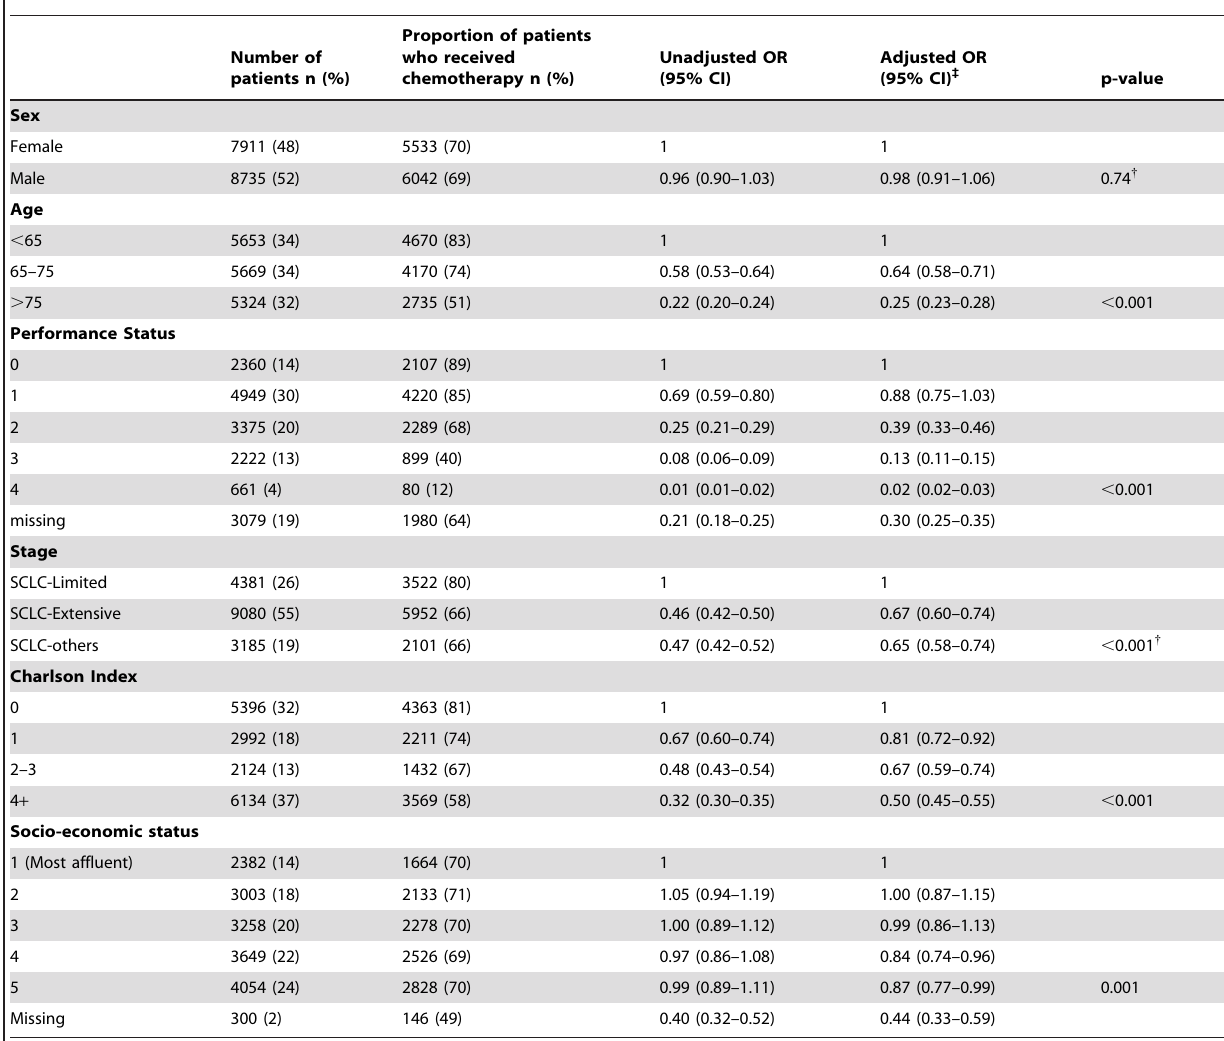
Table 2. Results for multivariate logistic regression analysis for patients diagnosed between 2006–2011